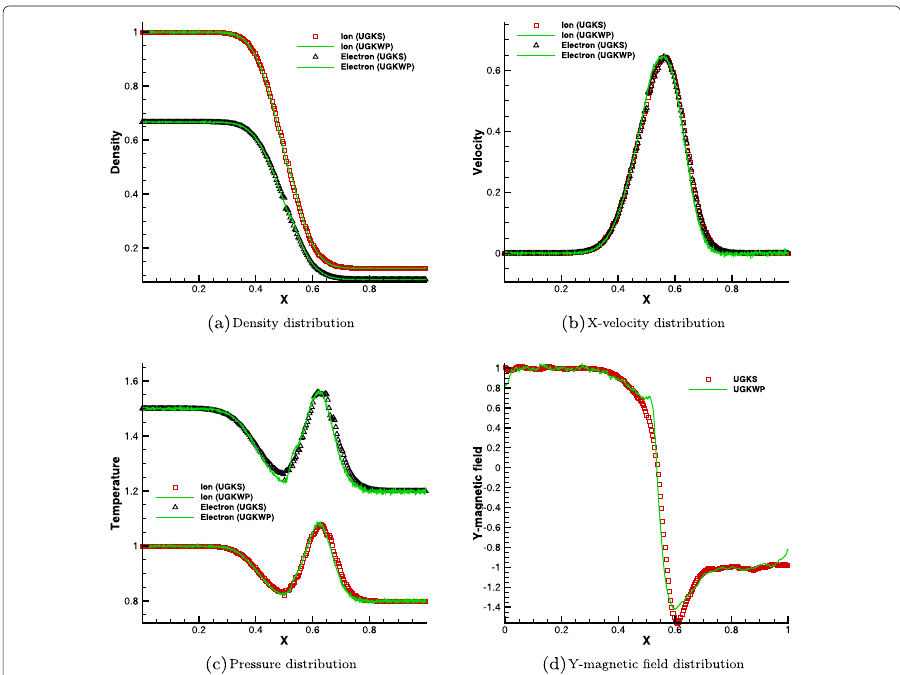
Fig. 9 Multiscale Brio-Wu shock tube problem with Kn=10 2 and r 10 3 . Lines show the UGKWP solutions and symbols show the reference UGKS solutions